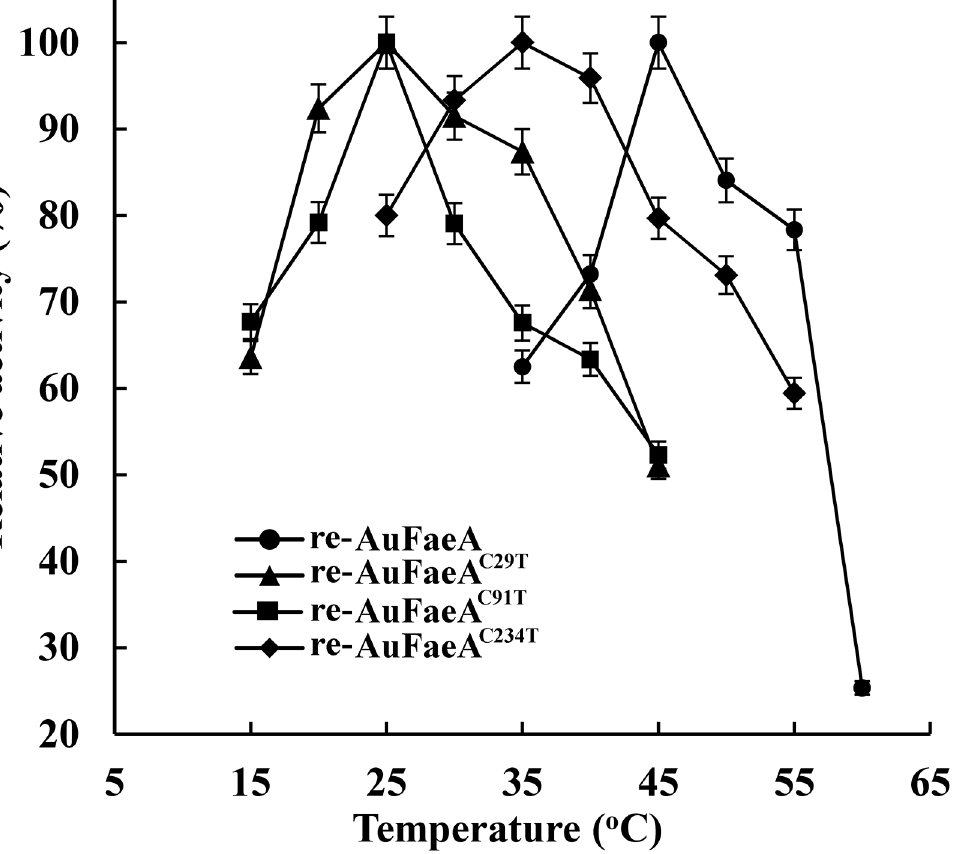
Fig 7. Temperature optima of the re-AuFaeA, re-AuFaeA C29T , re-AuFaeA C91T and re-AuFaeA C234T . The temperature optima were measured under the standard assay conditions, with varying temperatures ranging from 15 to